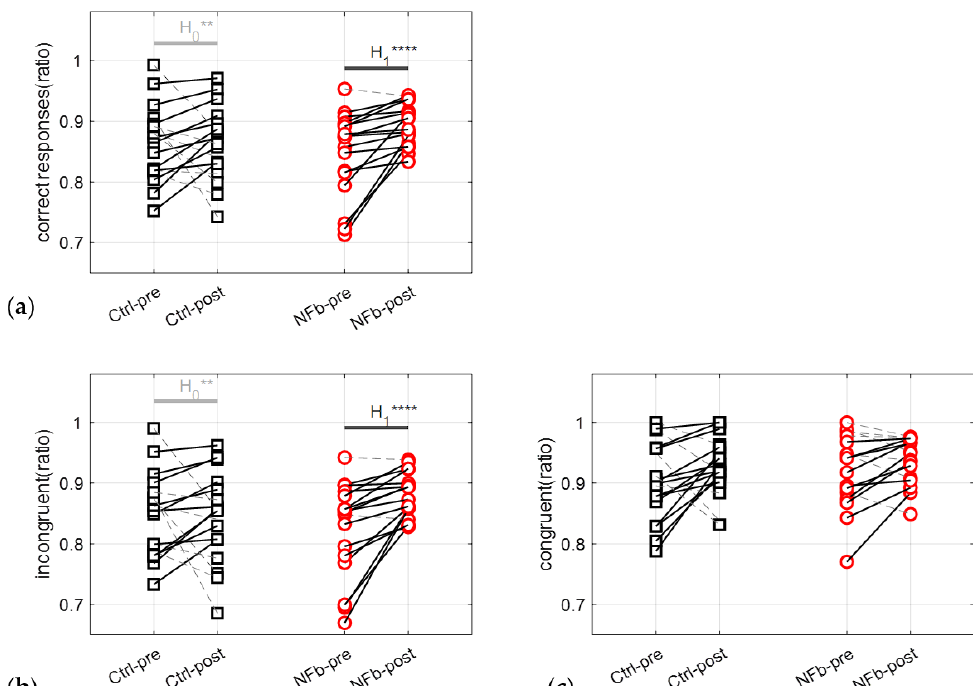
Figure 6. Proportion of correct responses provided by each individual participant in the pre- and post-training Stroop color and words tests (SCWT) for all trials ( a ), only incongruent trials (i.e., ink color does not match the displayed color word) ( b ) and only congruent trials (i.e., ink color matches the displayed color word) ( c ). For all trials ( a ) and incongruent trials ( b ), the NFb group showed significantly better performances than the control ( Ctrl ) group after training. For congruent trials, no differences were observed. An individual improvement in performance is highlighted by a solid line; a decline in performance is highlighted by a dashed gray line. Interpretation scale: In panels ( a ) and ( b ), H1 **** and H0 ** mean, respectively, extreme evidence for the alternative hypothesis and strong evidence for the null hypothesis. No evidence in panel ( c ).